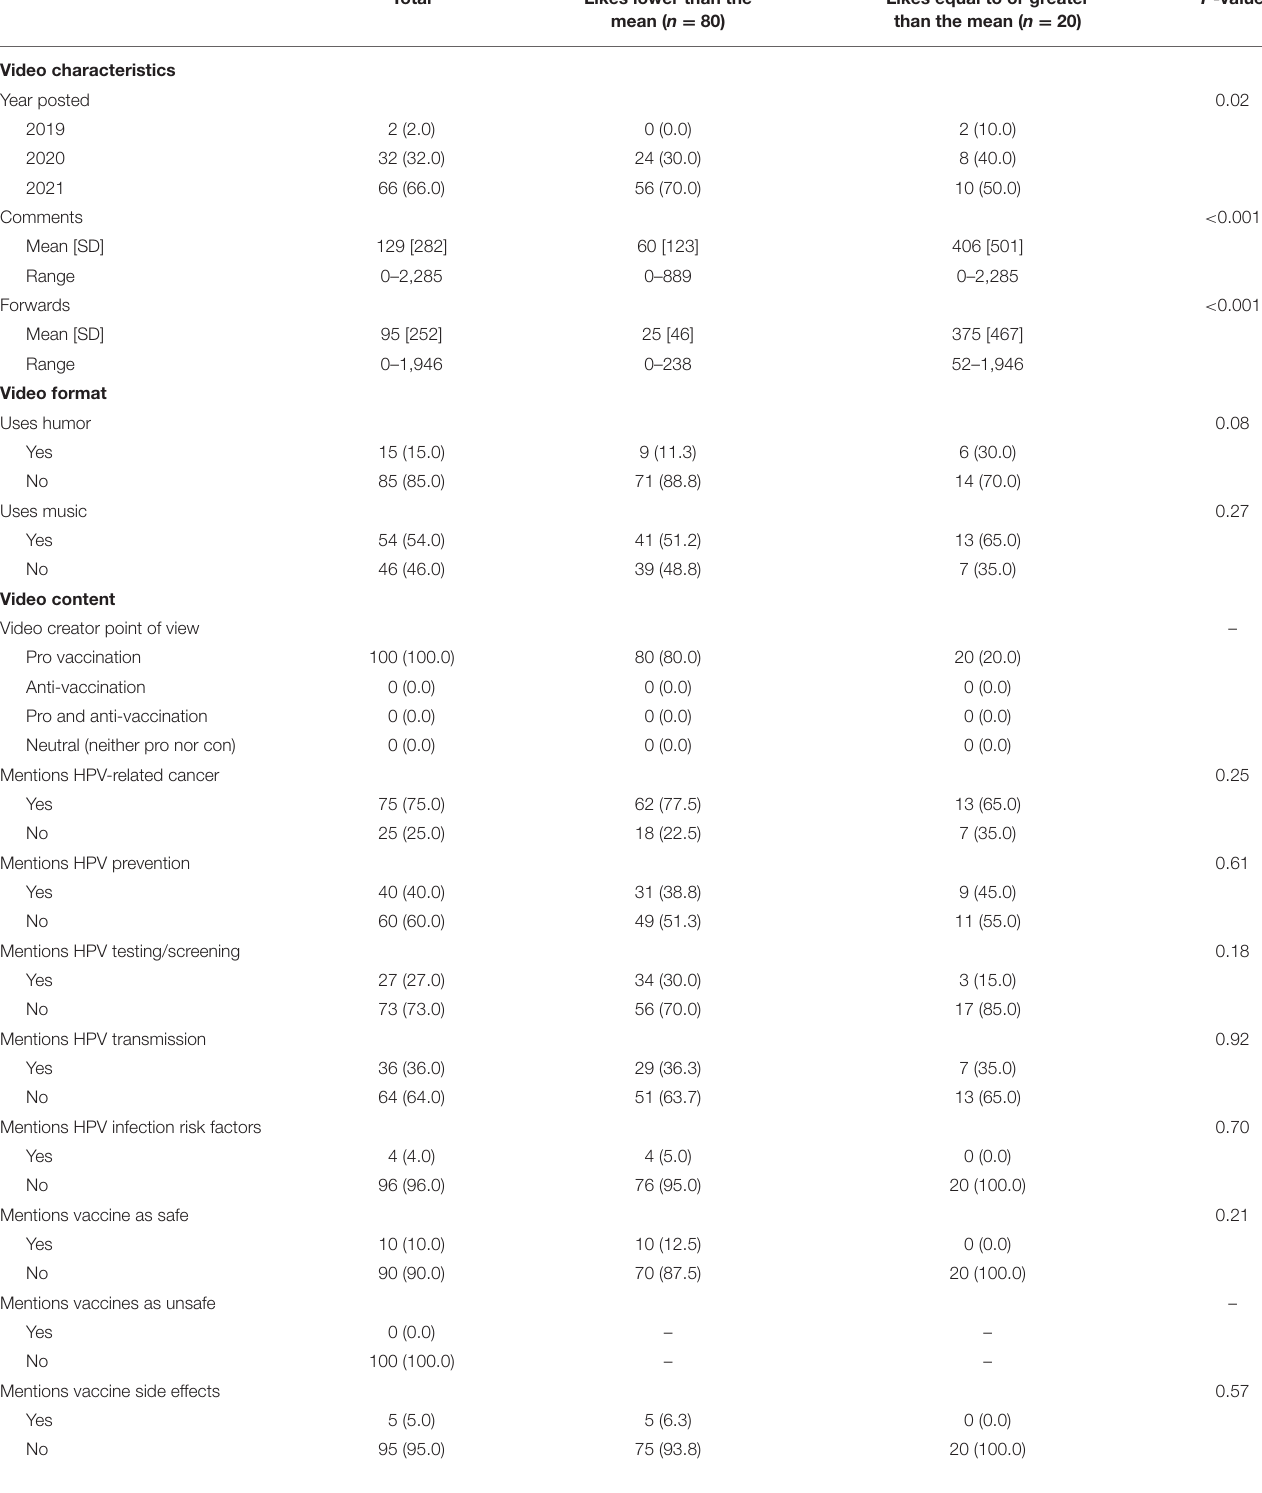
P Total Likes lower than the Likes equal to or greater mean ( n = 80) than the mean ( n = 20)